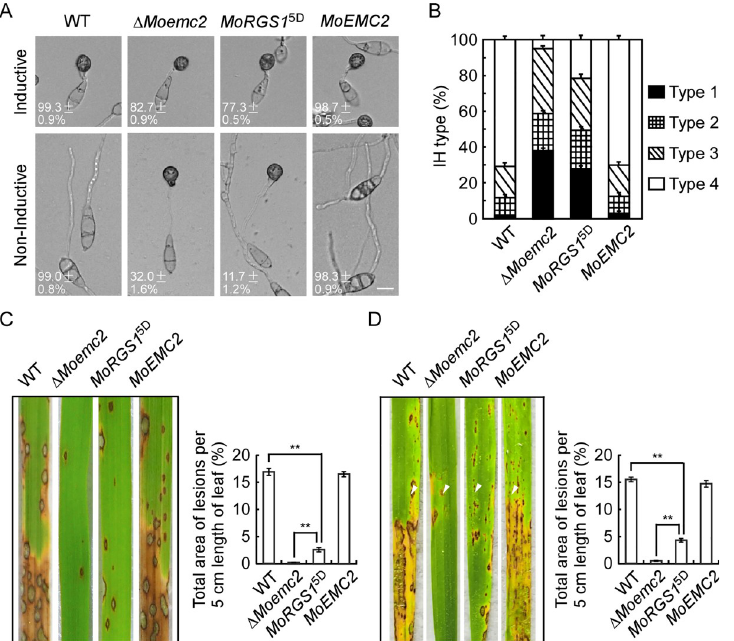
Fig 5. Activating MoRgs1 phosphorylation inhibits appressorium formation and pathogenicity deficiency in Δ Moemc2 mutant strains. (A) Appressorium formation assays and statistics analysis. Conidia of WT, Δ Moemc2 , MoRGS1 5D ( Δ Moemc2/MoRGS1 5D ), and complemented MoEMC2 ( Δ Moemc2/MoEMC2 ) strains were dropped on the hydrophobic and hydrophilic surfaces. The morphology of appressorium formation was observed at 24 h and photographed by confocal microscopy. Bar = 10 μ m. Conidia (n = 100) were observed and calculated with three replicates, and values are means of three replications and SD. (B) Detailed observation with statistical analysis for infectious hyphal growth in rice sheath cells at 24 hpi. Four milliliters of conidial suspension (1 × 10 5 spores/ml) of each strain were used for the injection. Appressorium penetration sites were observed, and IH were rated from type 1 to type 4 (n = 100). Error bars represent SD from three independent replicates. (C) Rice spraying assays and lesion area statistics. Conidial suspensions (5 × 10 4 spores/ml) were sprayed onto 2-week-old rice seedlings (CO-39). Diseased rice leaves were photographed, and percentages of per 5 cm length leaf lesion area were analyzed by ImageJ after 7 days of inoculation ( �� P < 0.01, n = 10). (D) Rice sheath injecting assays in vivo and lesion area statistics. Conidial suspensions (2 × 10 5 spores/ml) were sprayed onto 4-week-old rice seedlings (CO-39). Diseased rice leaves were photographed, and percentages of per 5 cm length leaf lesion area were analyzed by ImageJ after 5 days of inoculation ( �� P < 0.01, n = 10). White triangles point out the injection